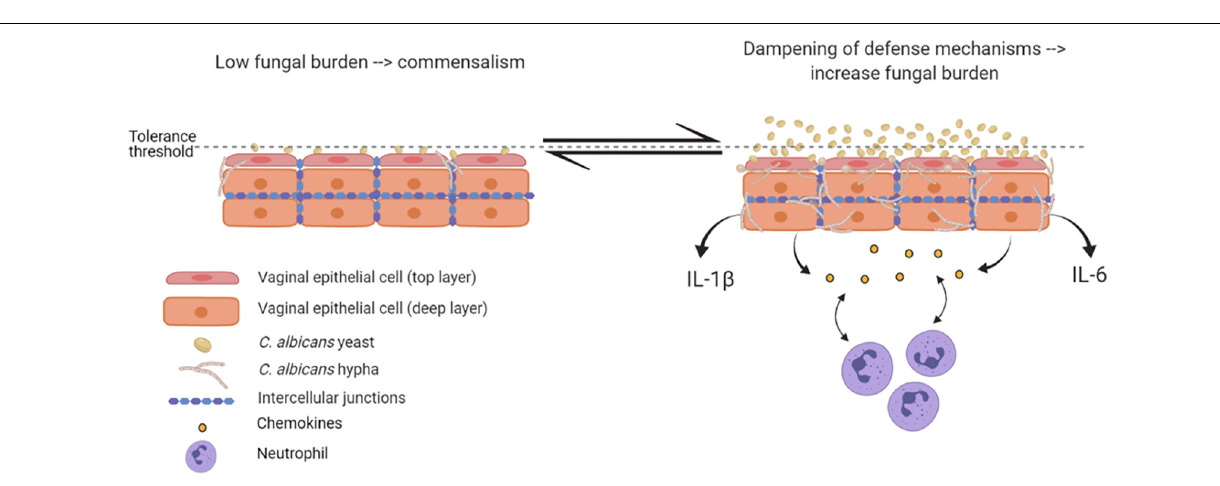
FIGURE 2 | Epithelial tolerance in murine model of VVC. C. albicans in its yeast form is tolerated by epithelial cells, which do not trigger any immune response. However, upon dampening of local defense mechanisms, fungal burden increases, yeasts-to-hyphae transition occurs, and the epithelial tolerance threshold is exceeded; as a consequence, epithelial cells trigger an intense inflammatory response, associated with proinflammatory cytokines and chemokines release and neutrophils recruitment (created with